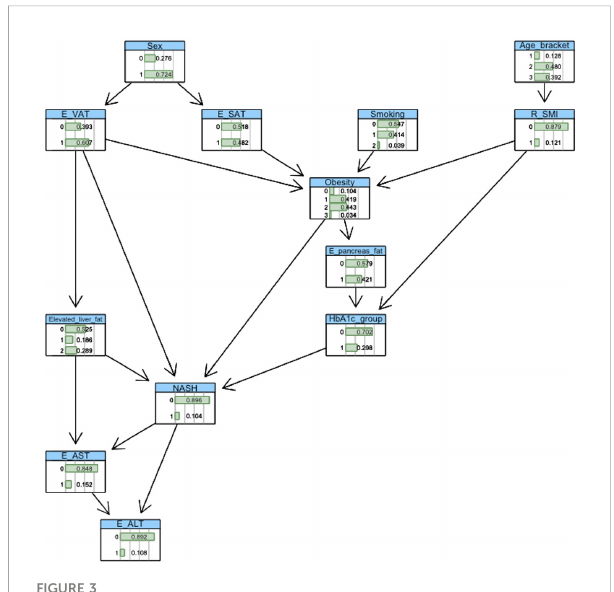
FIGURE 3 Bayesian-network structure from the non-T2D